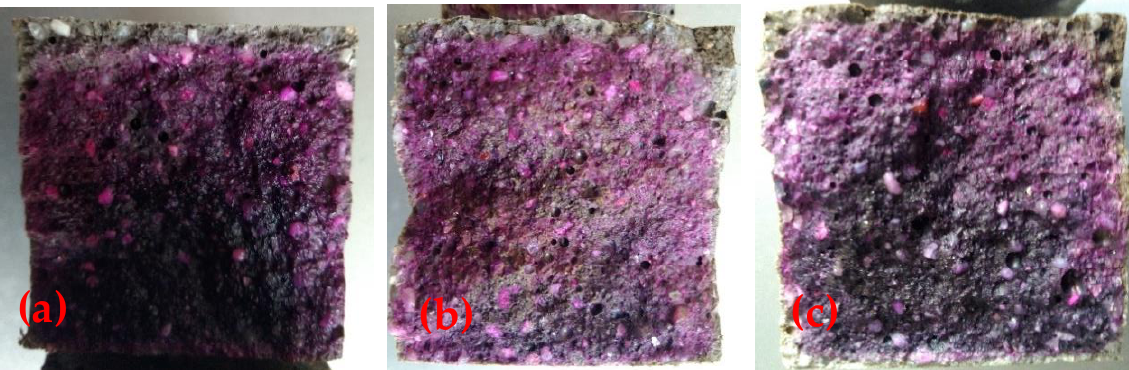
Figure 7. Visual presentation of pH decreases in the degraded layer ( a ) REC 1, ( b ) REC 2, ( c ) REC 3.